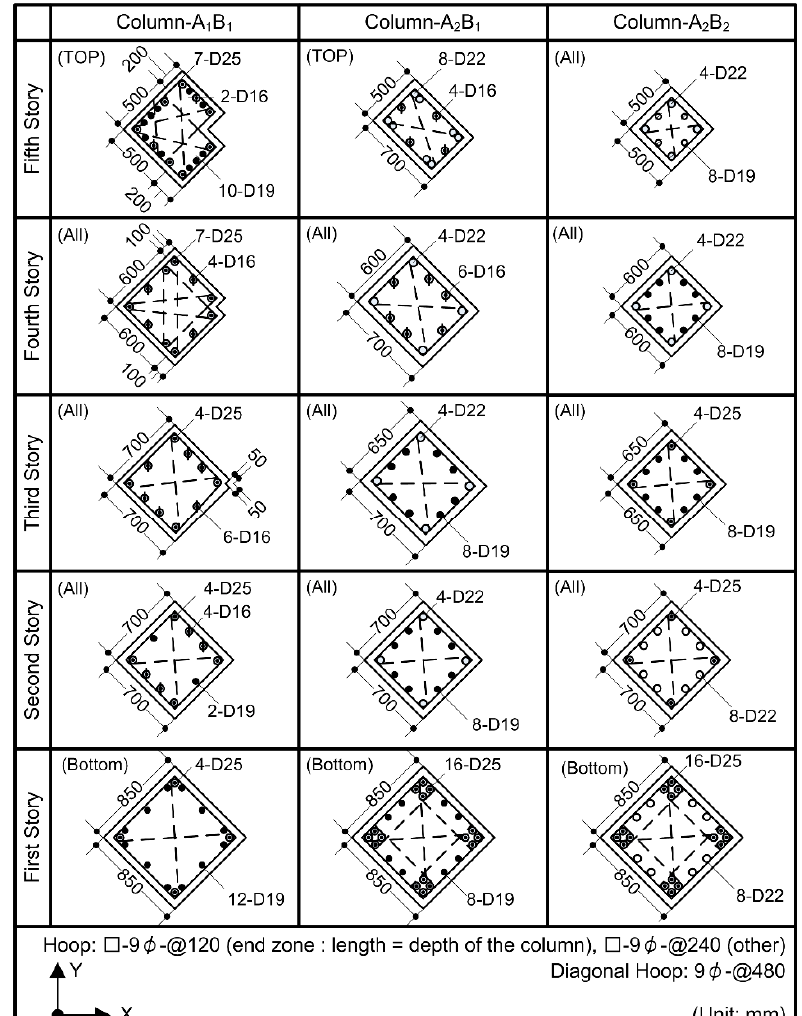
Figure 7. Sections of Column A 1 B 1 , A 2 B 1 , and A 2 B 2 [2].